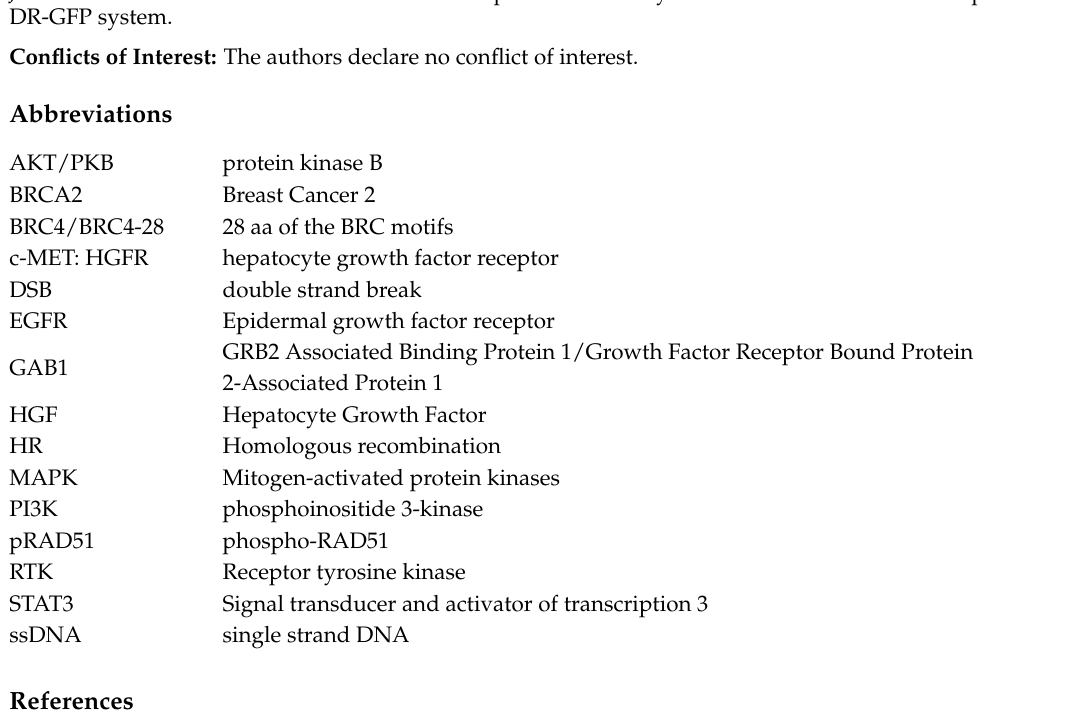
Figure S1: Purification of RAD51 mutants, Figure S2: CD spectra of ten RAD51 Y/F mutants and